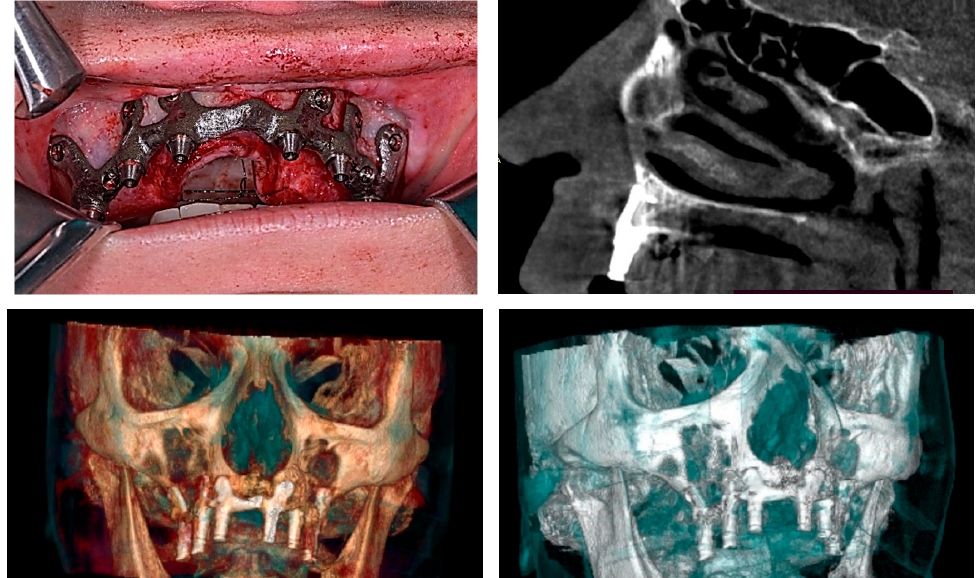
Figure 7. A patient with a total maxillary edentation treated with a subperiosteal implant (surgical stages and CBCT control after surgery).